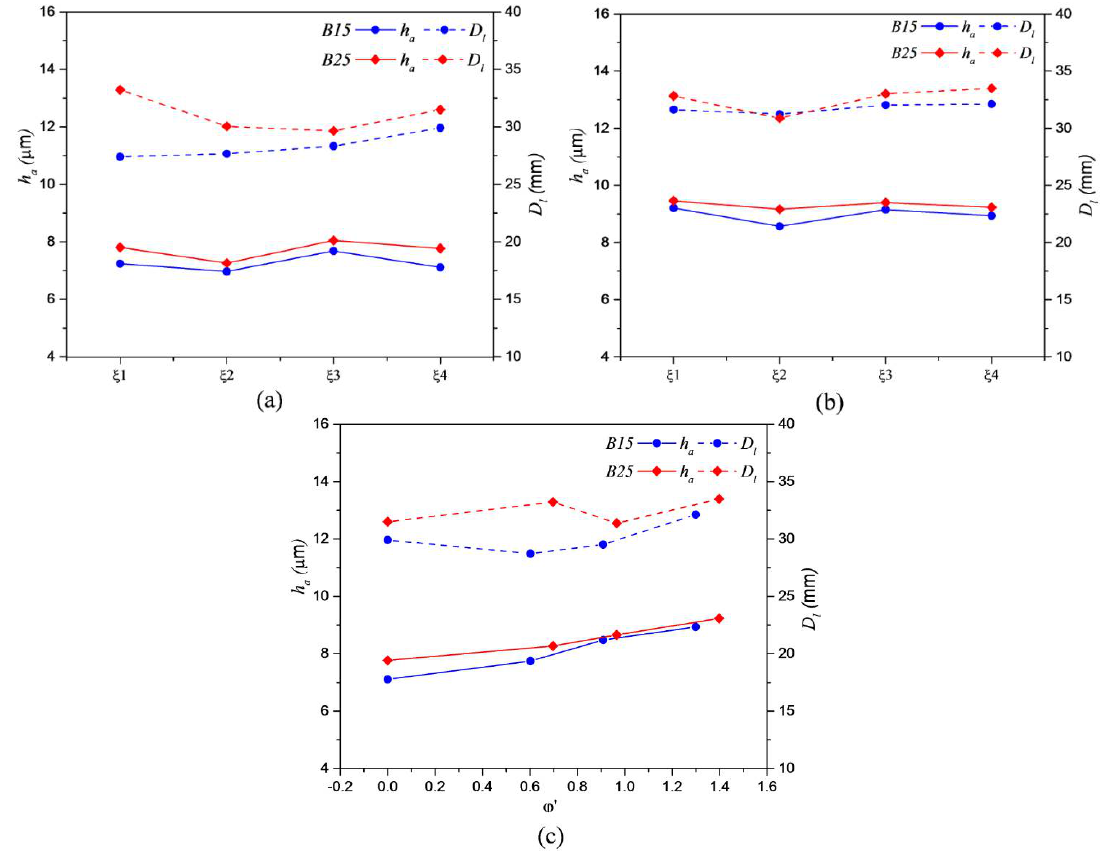
Figure 9. Mean thickness h a and accumulated diameter D l of adhered fuel film with different wall conditions: ( a ) dry walls with different roughness; ( b ) FWW with different roughness; ( c ) SWW with different φ’.